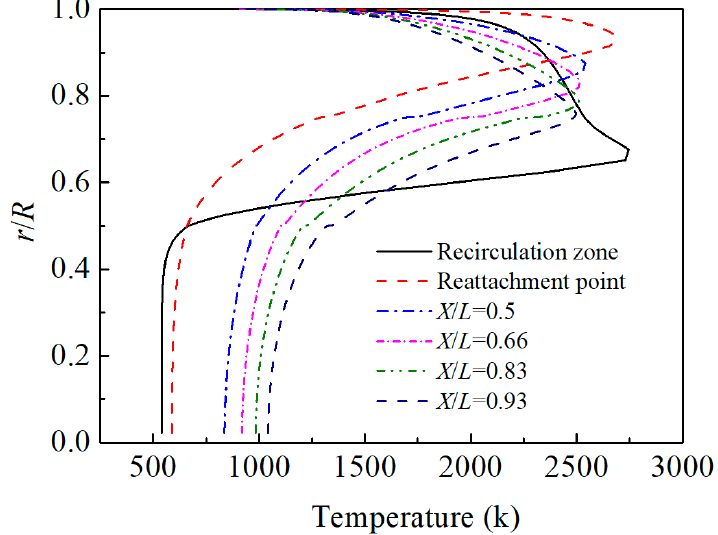
Figure 19. Temperature at different axial positions in the combustor. Energies 2019 , 12 , x FOR PEER REVIEW